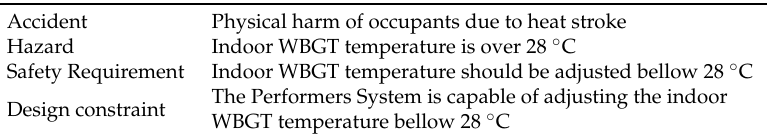
Table 4. Preparation for the STPA